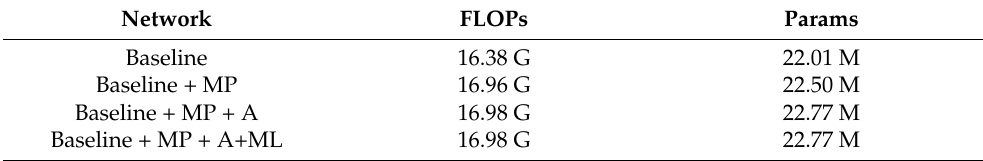
Table 4. Computational complexity analysis for ablation study. 1G = 2 30 ;1M = 2 20